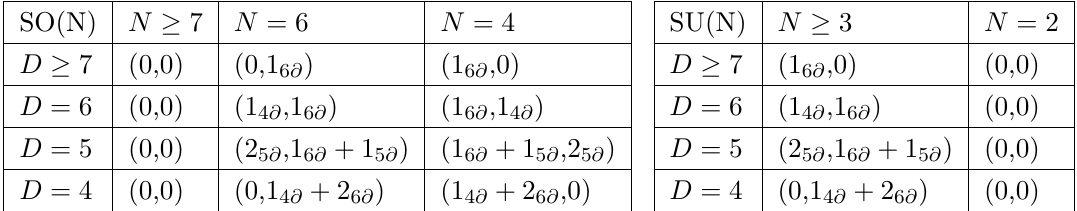
) of M non-inv along with their S 3 representation and A